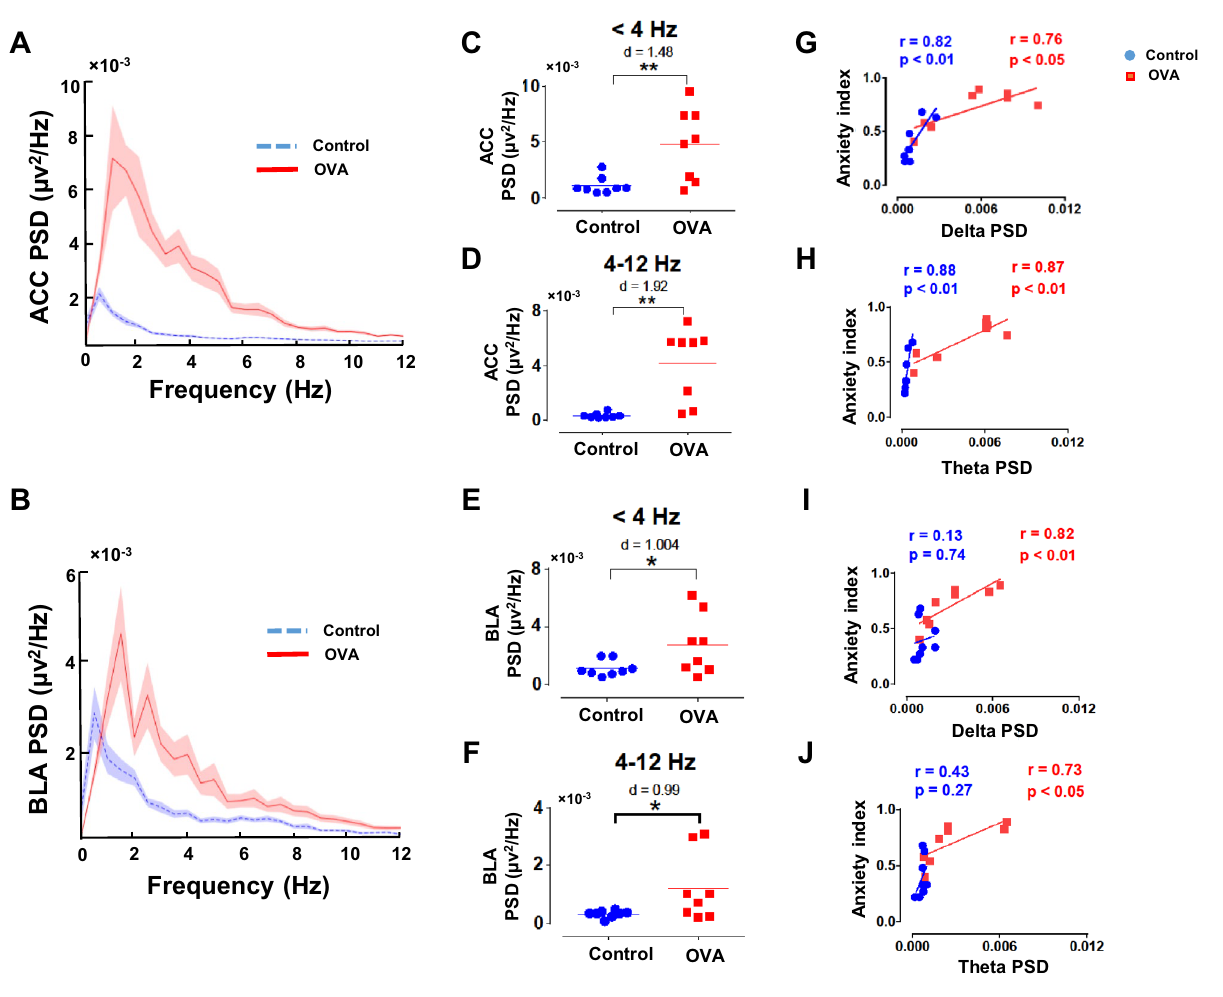
Figure 4. ACC and BLA neural activities. ( A, B ) PSD of recordings in the ACC ( A ) and BLA ( B ). Shaded areas show SEM. ( C-F ) Averaged PSD of ACC ( C, D ) and BLA ( E, F ) at delta (upper panels) and theta (lower panels) frequency bands. The horizontal bars indicate mean values. ( G-J ) Correlation between levels of anxiety and PSD of ACC ( G, H ) and BLA ( I, J ) at delta (upper panels) and theta (lower panels) frequency bands. Correlation coefficient (r) was performed using Pearson correlation coefficient analysis. Data were analyzed by t-test, n = 8 per group. *p < 0.05, **p < 0.01 compared to control. OVA, ovalbumin; ACC, anterior cingulate cortex; BLA, basolateral amygdala; PSD, power spectral